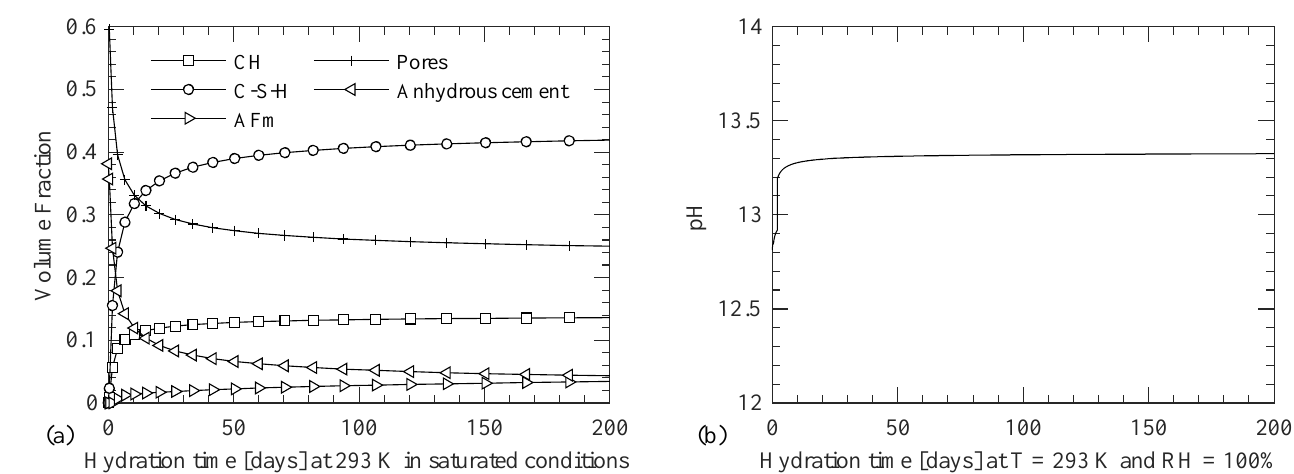
Figure 12. Evolution of ( a ) cement paste hydration products (CH: calcium hydroxide, C-S-H: calcium-silicate-hydrate, and AFm: mono-sulfate aluminate) and ( b ) pH of CPS at 293 K and 100% RH.